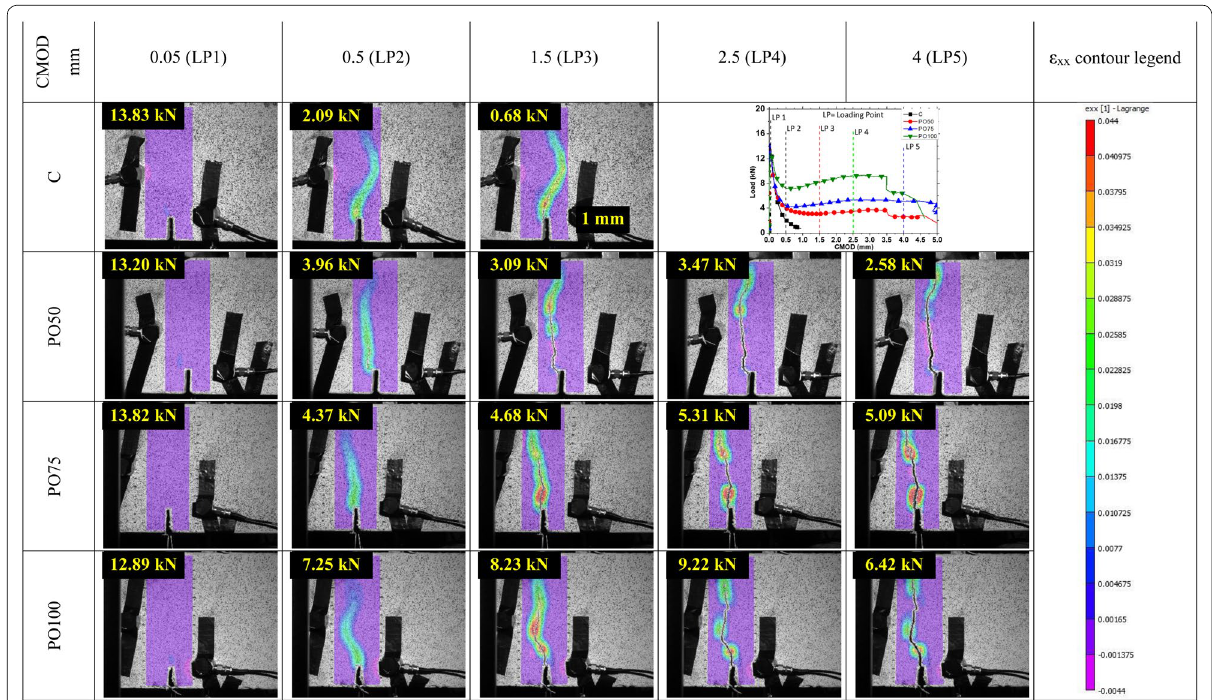
Fig. 9 Comparison of strains of SynFRC with different fibre dosages at considered